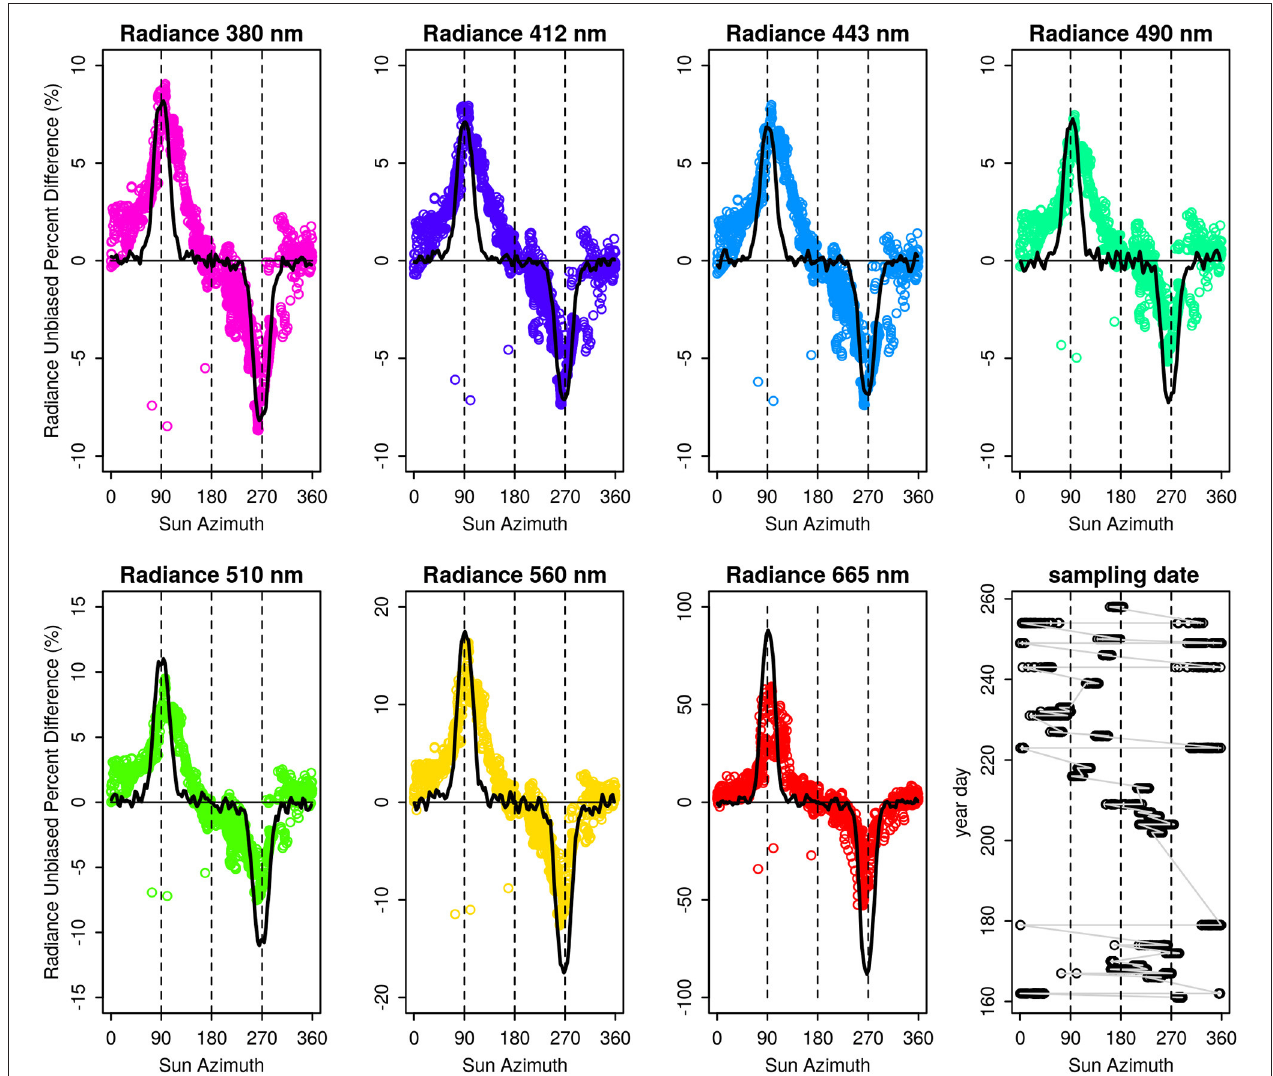
FIGURE 10 | UPD calculated from local polynomial regression fitting of radiance data measured above 10m depth for 31 profiles of the float lovapm006f as a function of the solar azimuth angle. The black line represents the theoretical effect of shading estimated by the SimulO software at 2 m depth and for a sun zenith angle of 45 degrees. See Figure 3 for sun azimuth definition. Bottom right, day of the acquisition for each sun azimuth